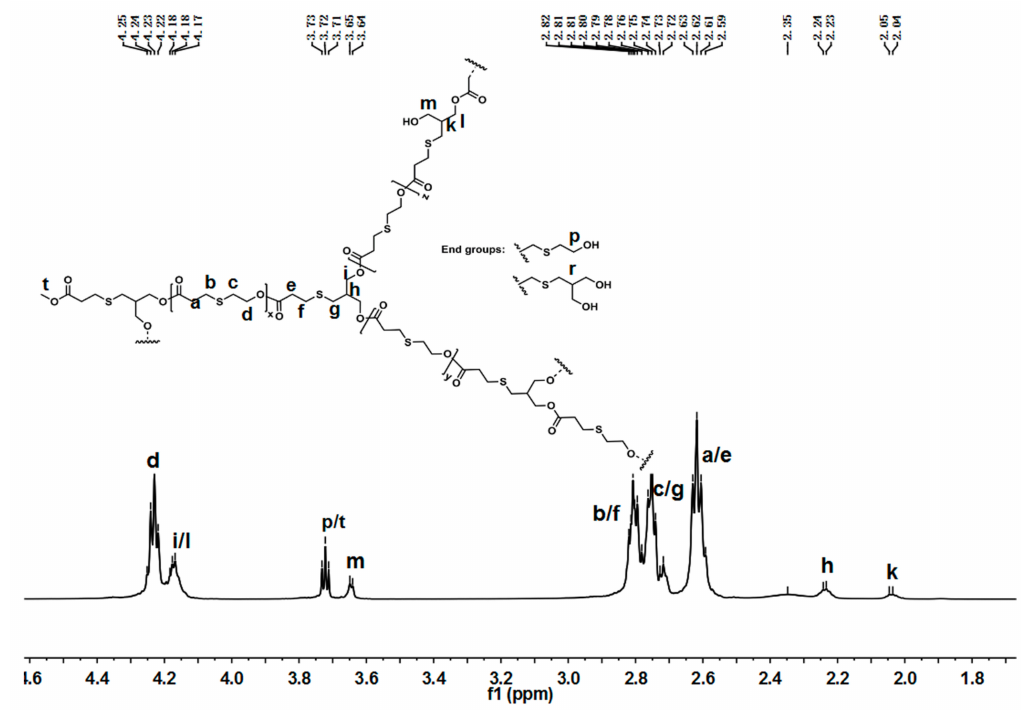
Figure 2. 1 H-NMR of hPTE-1 in CDCl 3